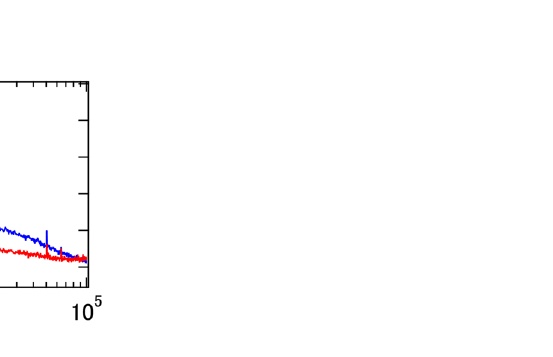
Figure 5. SSB phase noise PSD of the DUT with (i, red) and without (ii, blue) feedback measured via an out-of- loop